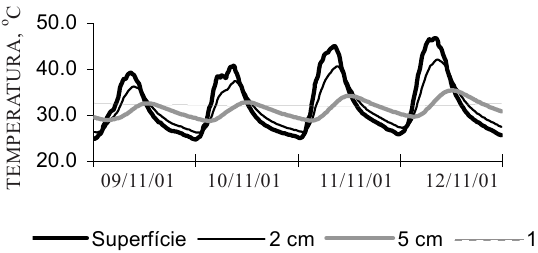
Figura 2. Evolução das temperaturas do solo na superfície e nas profundidades de 2, 5 e 15 cm.